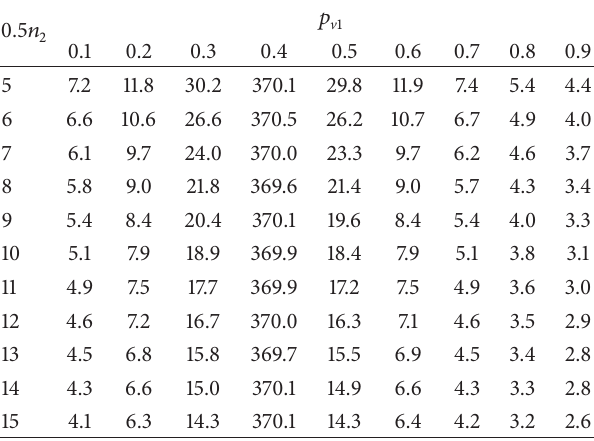
Table 8: The ARL V 1 of the EWMA-AV chart for 𝜆 2 = 0.05 and 𝑝 V 0 =